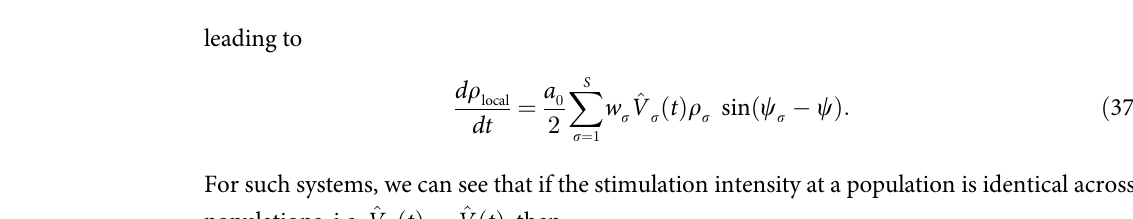
Fig 3. Different configurations of oscillators color coded according to population. Panels (a) and (b) are for a unimodal distribution and multimodal (clustered) distribution, respectively. Configurations were obtained by simulating the multi-population Kuramoto Eq (20).